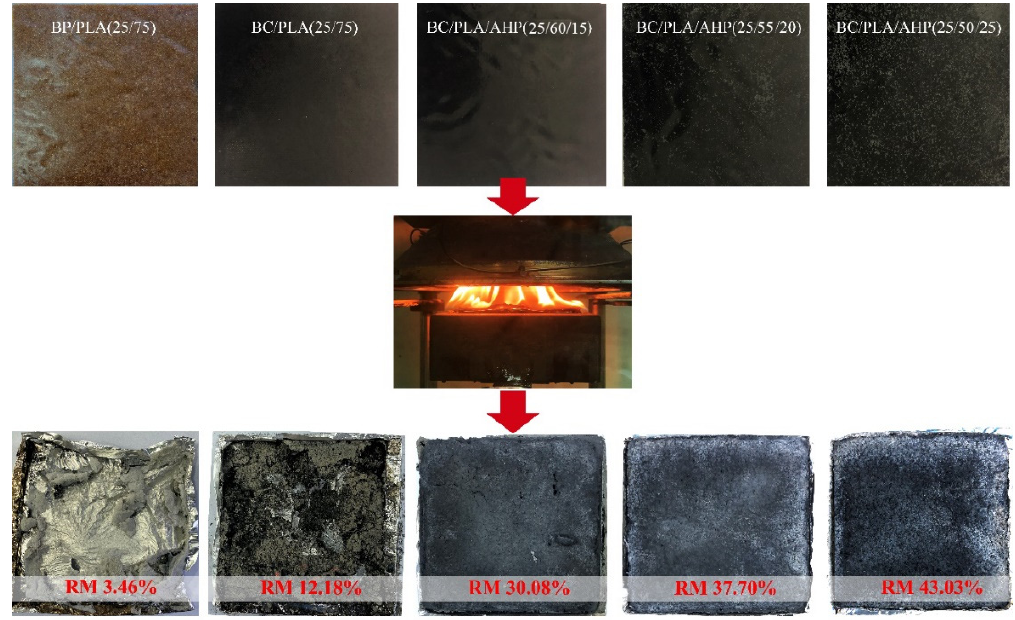
10 of 19 Figure 6. Images of BC/PLA composites after UL94 test: ( a ) BC/PLA (25/75), ( b ) AHP/BC/PLA (25/70/05), ( c ) AHP/BC/PLA (25/65/10), ( d ) AHP/BC/PLA (25/60/15), ( e ) AHP/BC/PLA (25/55/20) and ( f ) AHP/BC/PLA (25/50/25). Figure 6a shows the melt dripping behaviour of the BC/PLA (25/75) mix. With the addition of AHP (Figure 6b–f) melt dripping almost completely disappeared and a carbonized layer was formed at the top of the sample to delay or eliminate the upward spread of the burning flame. AHP significantly increases the melt viscosity of the composite [25]. Previous work by Liu et al. (2016) [41] found that adding AHP on its own up to 20% cannot completely suppress melt dripping of PLA. However, Tang et al. (2012) [26] was able to completely suppress melt dripping during the UL 94 test by adding 20% AHP to PLA. Nevertheless, the BC powder plus the AHP appears to have a strong synergistic effect to more effectively suppress the melt dripping and flame spread of PLA, improving its flame-retardant properties. The addition of 5% AHP is insufficient with the LOI value of the mix being similar to pure PLA at 23.4 vol%, reaching only UL 94 V-2 rating. At 20% AHP addition to the BC/PLA (25/75) mix, the LOI exceeded 29 vol%, giving it a UL 94 V-0 rating. 3.4. Cone Calorimetery Testing